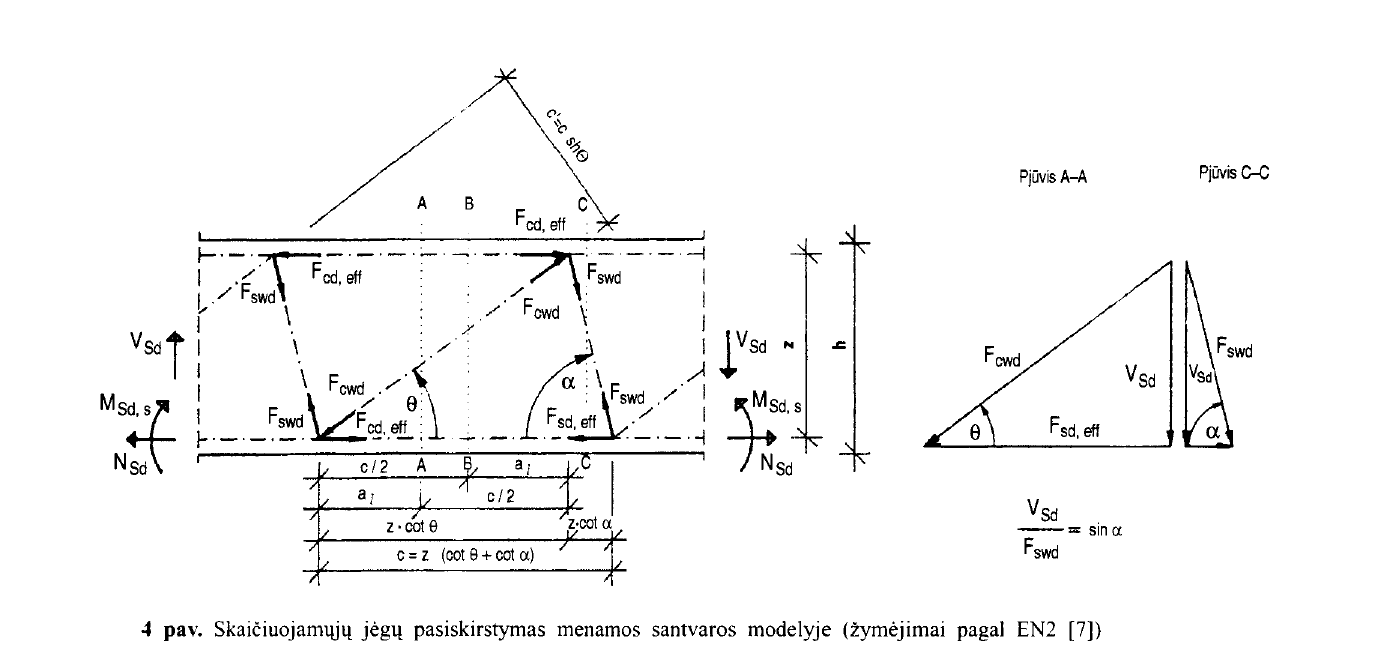
4 pav. SkaiciuojamlJ.itt jeg11 pasiskirstymas menamos santvaros modelyje (zymejimai pagal EN2 [7]) Fig 4. Distribution of design forces in imaginary truss model (designationsin EN2 [7])